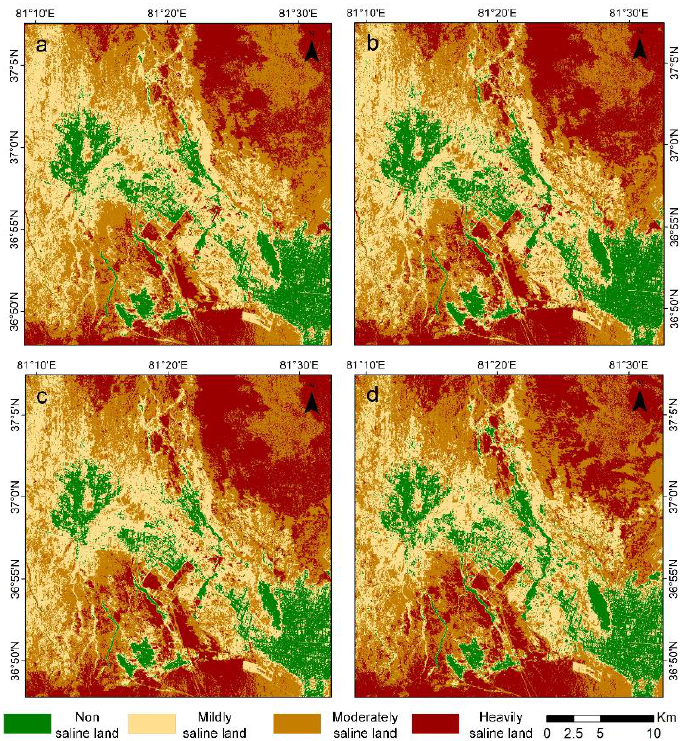
Figure 14. Spatial distribution of soils with different salinity levels based on different feature space models: ( a ) ORSDI1; ( b ) ORSDI 2; ( c ) ORSDI 3; ( d ) ORSDI4.